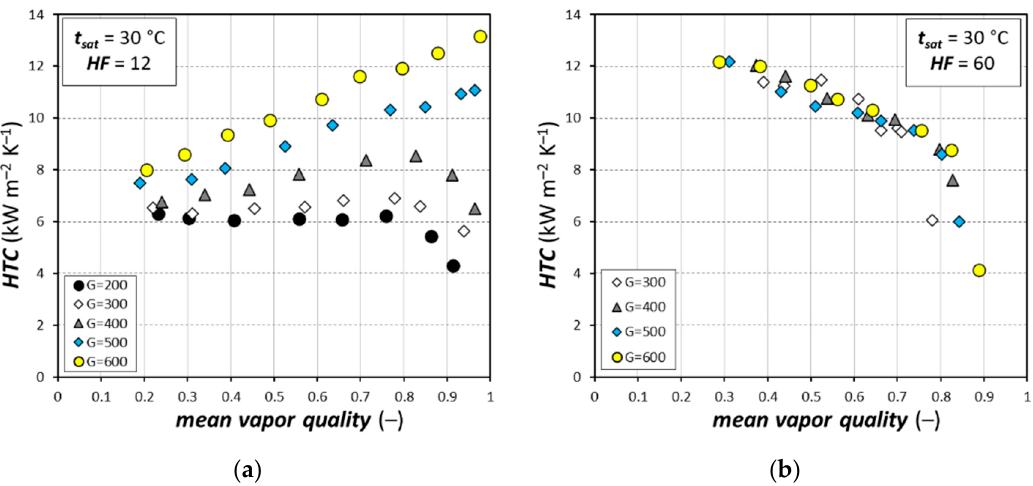
Figure 3. Heat transfer coefficient versus mean vapor quality at t sat = 30 °C for different mass velocities. ( a ) Data at HF = 12 kW m − 2 ; ( b ) data at HF = 60 kW m − 2 . G expressed in (kg m − 2 s − 1 ).